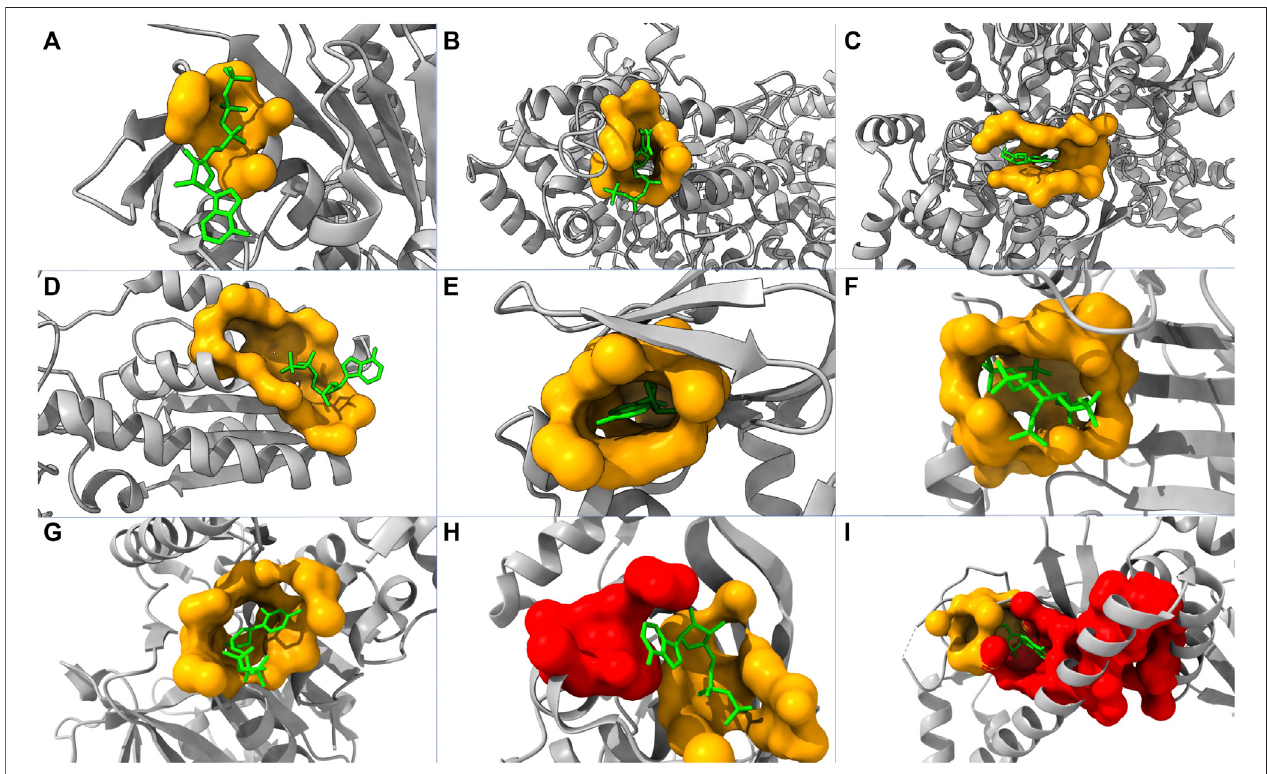
FIGURE4| Structuresofnineproteinswithmodulatorsandpredictedpockets.PDBIDsoftheseproteinsare: (A) 2FPL, (B) 2R1R, (C) 3BCR, (D) 4PFK, (E) 1Q5O, (F) 3PEE, (G) 4HO6, (H) 1XMV, and (I) 2OZ6. The yellow pockets are labeled as allosteric, and the lime molecules are modulators. For (A – G) , the allosteric pockets are successfully predicted as top one by our model. For (H,I) , the red pockets are predicted as the fi rst place, and the allosteric pockets are predicted as the second place.